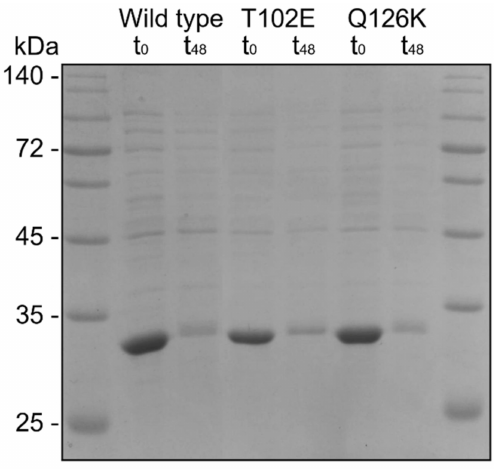
Figure 4. SDS-PAGE visualizing the protein content of clarified and dialyzed E. coli cell lysates of Lk ADH wild type and mutants T102E and Q126K. Depicted are samples of clarified and dialyzed E. coli cell lysates directly before crystallization initiation (t 0 = 0 h) and after 48 h (t 48 ) of crystallization in stirred tank reactors (V = 5 mL, n Stirrer = 150 rpm, 20 ◦ C, 100 g L − 1 PEG MME 550). Lk ADH variants are detected between 25–35 kDa, corresponding to its molecular monomer weight of 27.86 kDa (calculated with ExPASy